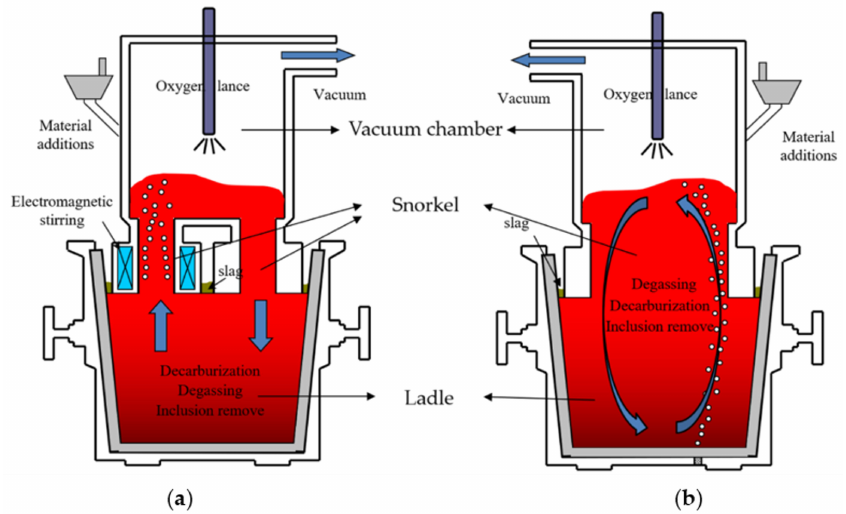
Figure 1. Schematic of typical vacuum refining furnace ( a ) RH; ( b ) single-snorkel vacuum refining furnace